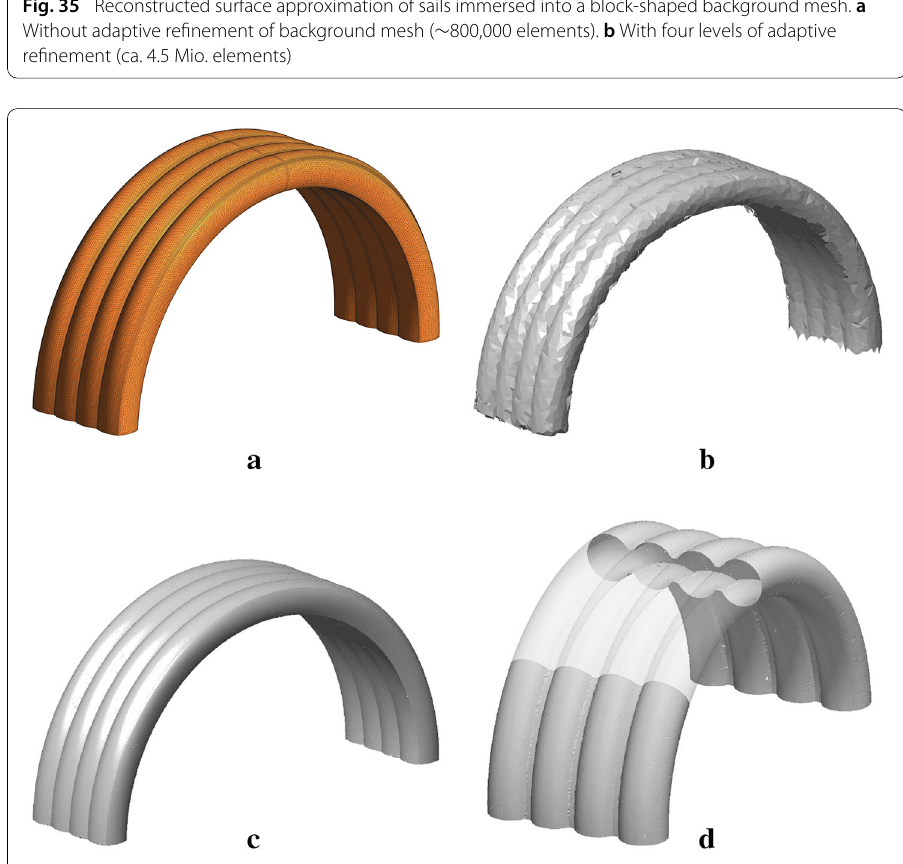
Fig. 36 Section of an inflatable hangar model and its implicit representation in a background mesh. a STL model. b Reconstruction of approximated geometry without refinement of background mesh ( ∼ 800,000 elements). c Reconstruction of approximated geometry after adaptive refinement ( ∼ 9 Mio. elements). d A look inside the approximated